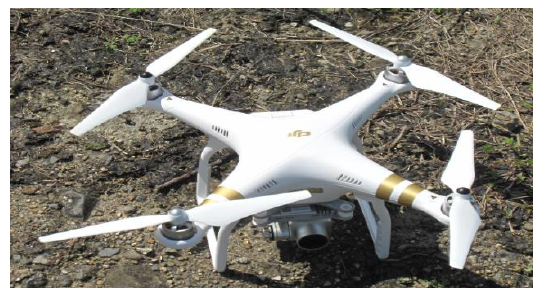
Figure 3. Phantom3 Professional UAV